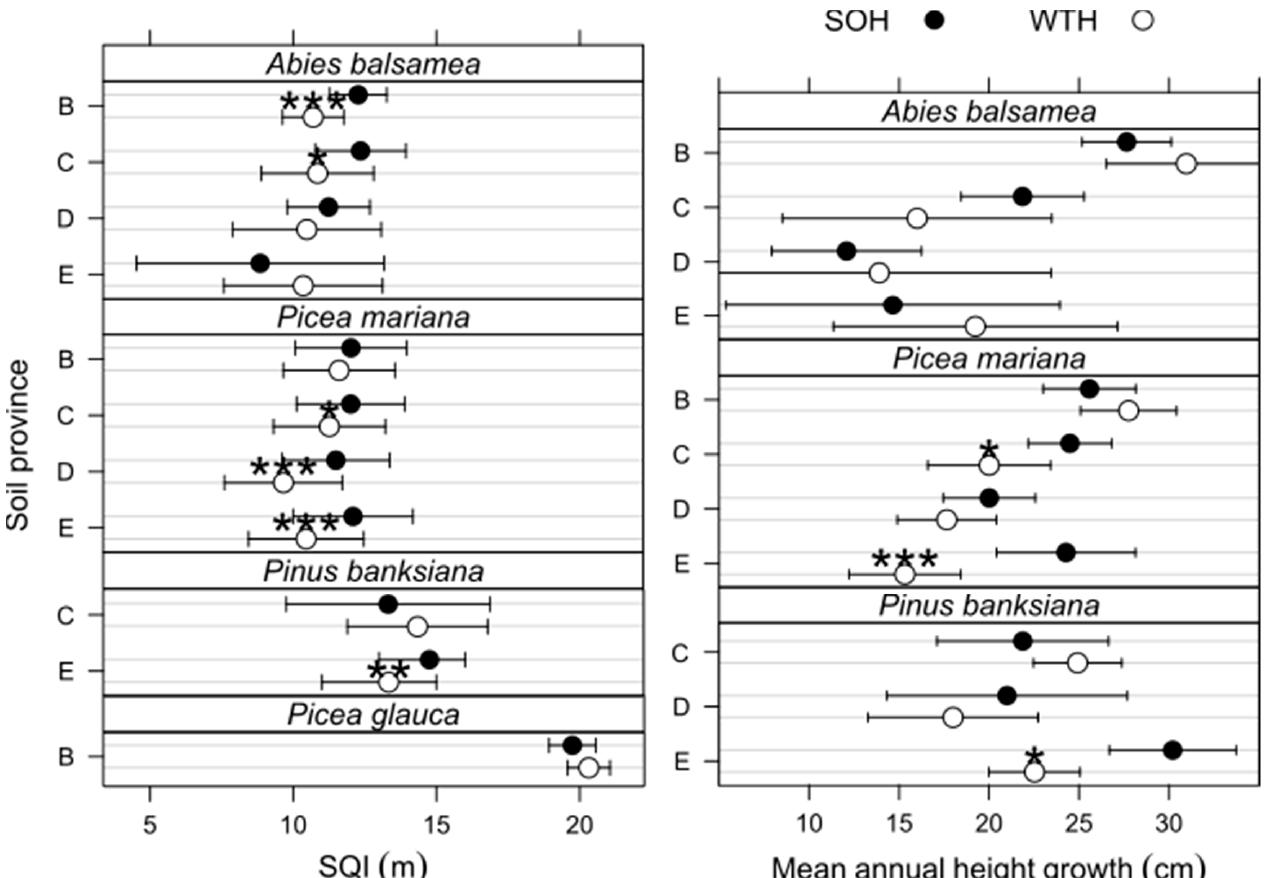
Figure 4. Site quality index (SQI) and mean annual height growth of various tree species as a function of harvesting treatment (stem-only harvesting (SOH) and whole-tree harvesting (WTH)) in four soil provinces of Quebec: B = Appalachians; C = Laurentians; D = Abitibi Lowlands; E = Mistassini Highlands. Data presented are model-adjusted means ± 95% confidence intervals. Asterisks indicate significant differences between harvesting treatments within a given soil province: * p ≤ 0.05, ** p ≤ 0.01, *** p ≤ 0.001.